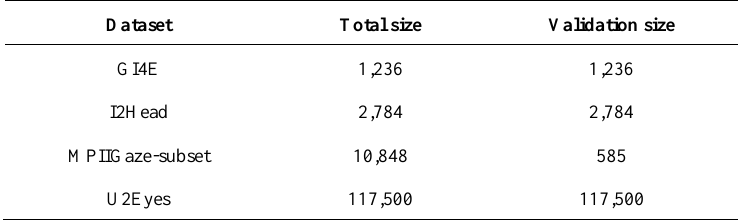
Table 1. A summary of the total number of images within the datasets and the images used during our validation